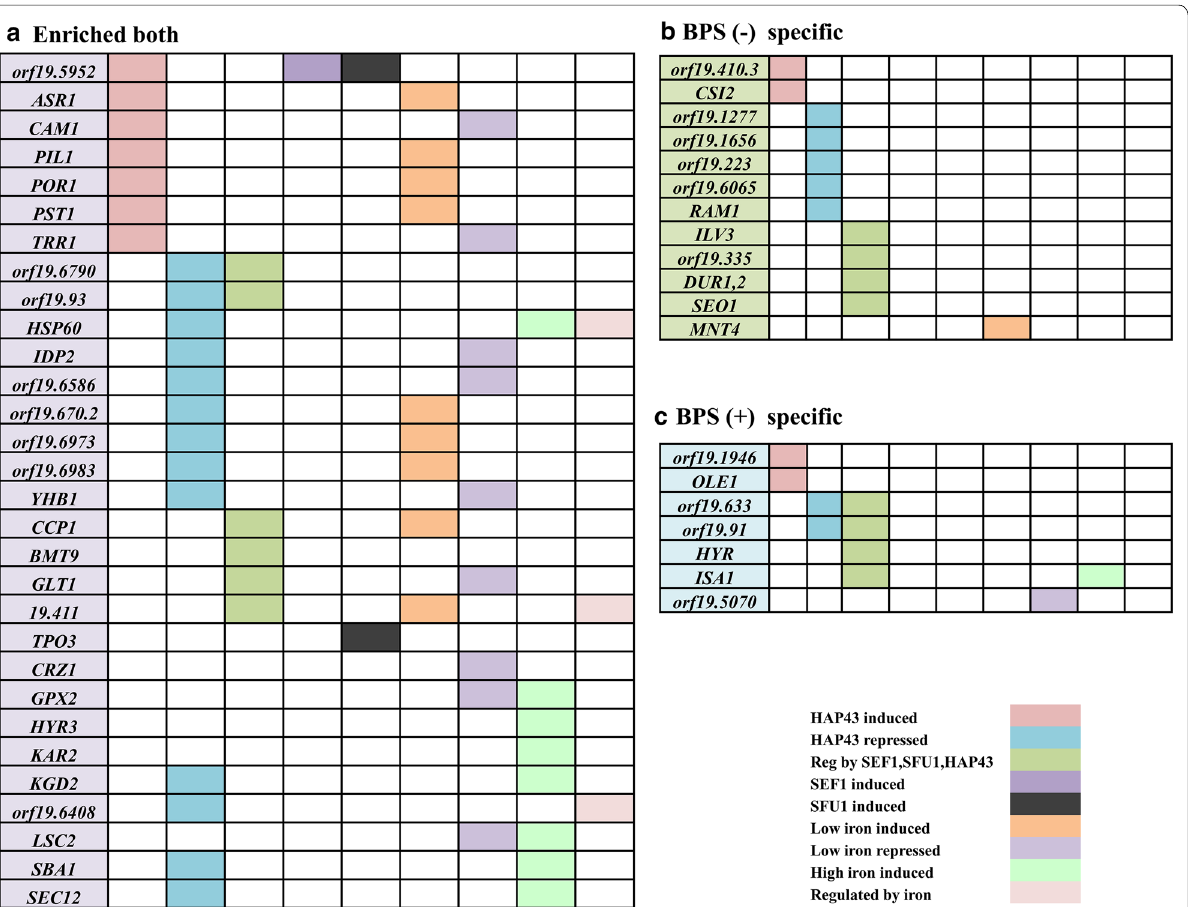
Fig. 4 Iron responsive genes elicit Hsf1 binding sites—genes from the three categories [Enriched both ( a ), BPS ( are examined for either induction or repression by major iron regulators or regulated by iron. They are grouped into various categories and then